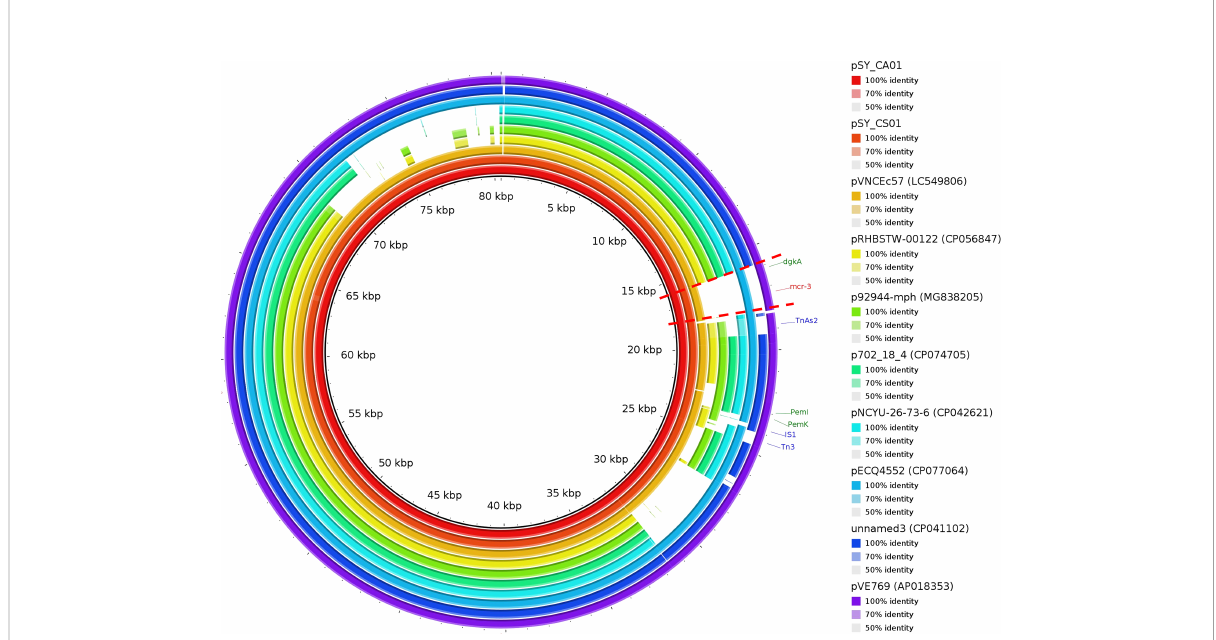
FIGURE 7 Circular comparison of IncFII(pCoo) harboring mcr-3.5 , pSY_CS01 and pSY_CA01 with eight homologous plasmids with considerable query